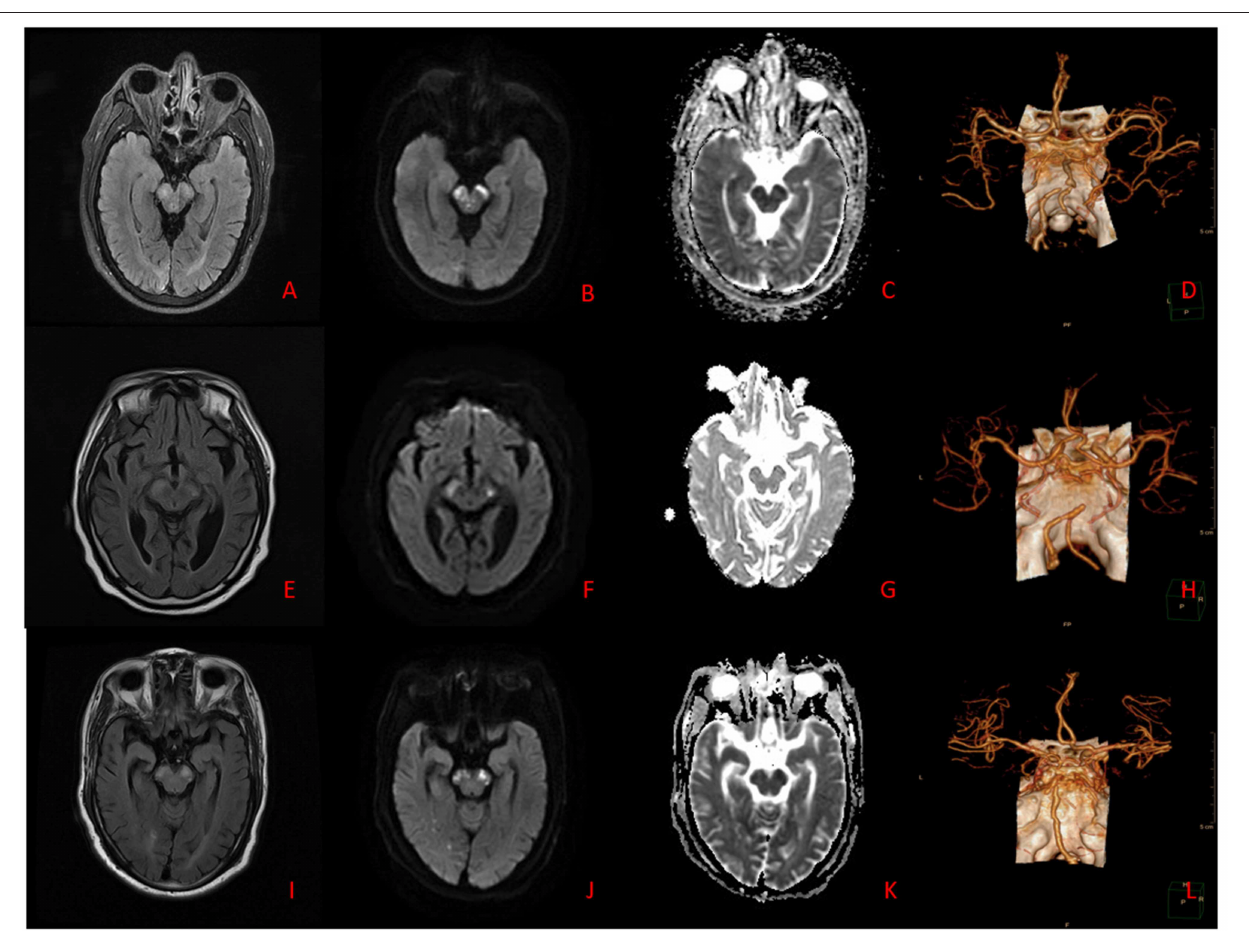
FIGURE 1 | (A–D) Case 7. Brain MRI: The lesions appear hyperintense on T2WI, T2-FLAIR, and DWI, and hypointense on ADC. Brain CTA: Stenoses are located in bilateral VA. (E–H) Case 8. Brain MRI: The lesions appear hyperintense on T2WI, T2-FLAIR, and DWI, and hypointense on ADC. Brain CTA: Stenosis is located in BA. (I–L) Case 10. Brain MRI: The lesions appear hyperintense on T2WI, T2-FLAIR, and DWI, and hypointense on ADC. Brain CTA: Stenoses are located in right VA and